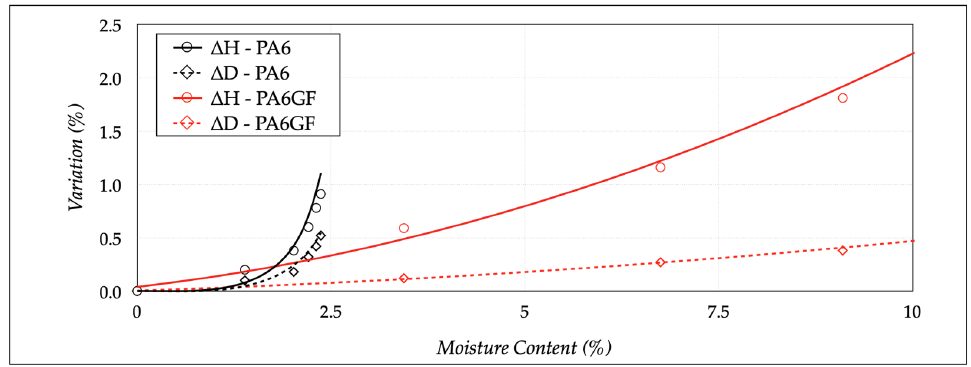
Figure 7. Dimensional variations with moisture